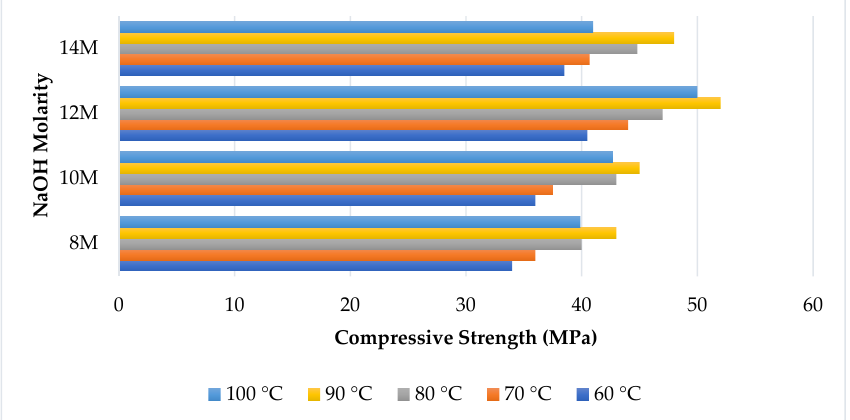
Figure 6. Effect of NaOH molarity and curing temperature on 28th day compressive strength of FA/slag-based AAM [100,101] .